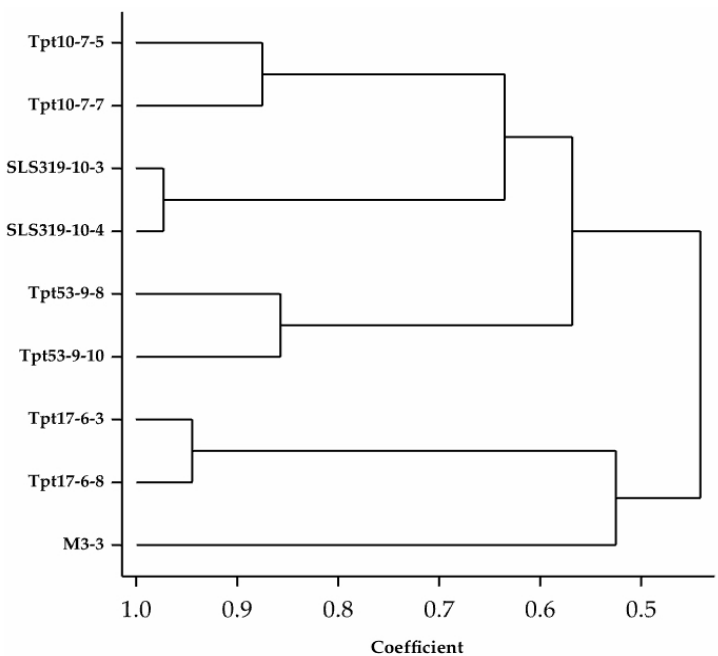
Figure 3. A dendrogram of the genetic relationship between genotypes from Papua New Guinea (Tpt10), Sri Lanka (SLS319), Bangladesh (Tpt53), Indonesia (Tpt17), and Malaysia (M3).